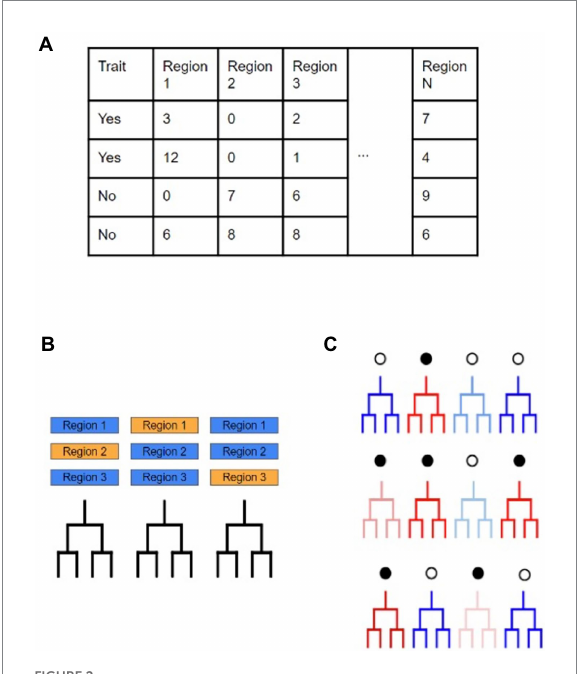
FIGURE 2 Workflow to determine evolutionary predictors for M. bovis across scales. (A) Here the dataset is divided based on a binary trait of ‘yes’ or ‘no’ with accompanying predictor variables that may provide support in making classifications on the trait. In this study, these predictors are as follows: the number of SNPs in a SNP dense region, the number of INDELs in a SNP dense region, the number of SNPs in a selective sweep region, the number of SNPs in coding regions, the number of SNPs in non-coding regions, the number of INDELs in coding regions, the number of INDELs in non-coding regions, and the genome wide GC%. (B) Random Forest models use multiple, uncorrelated decision trees created from randomly subset predictors of the original data. Due to the individual trees being unrelated to each other, their combined predictive ability leads to excellent classification ability. (C) Since each individual decision tree is created from random subsets of the predictors, the accuracy of individual trees will vary greatly (red and blue represent low and high accuracy, respectively). The amount of increase and/or decrease in model accuracy when a specific predictor is included is determined by tracking which predictors are included in the simple decision